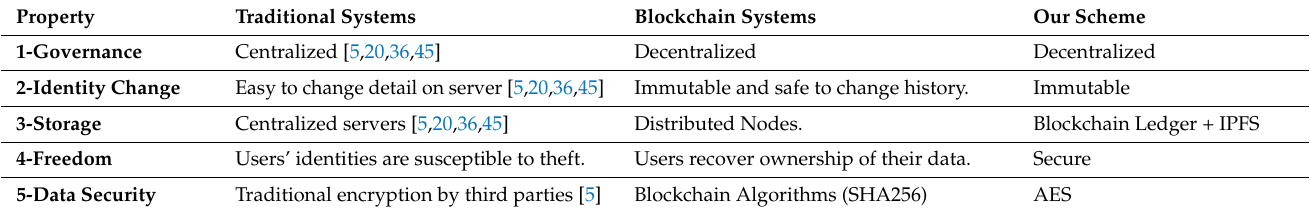
Table 1. Comparing Blockchain system vs. traditional system as centralized and